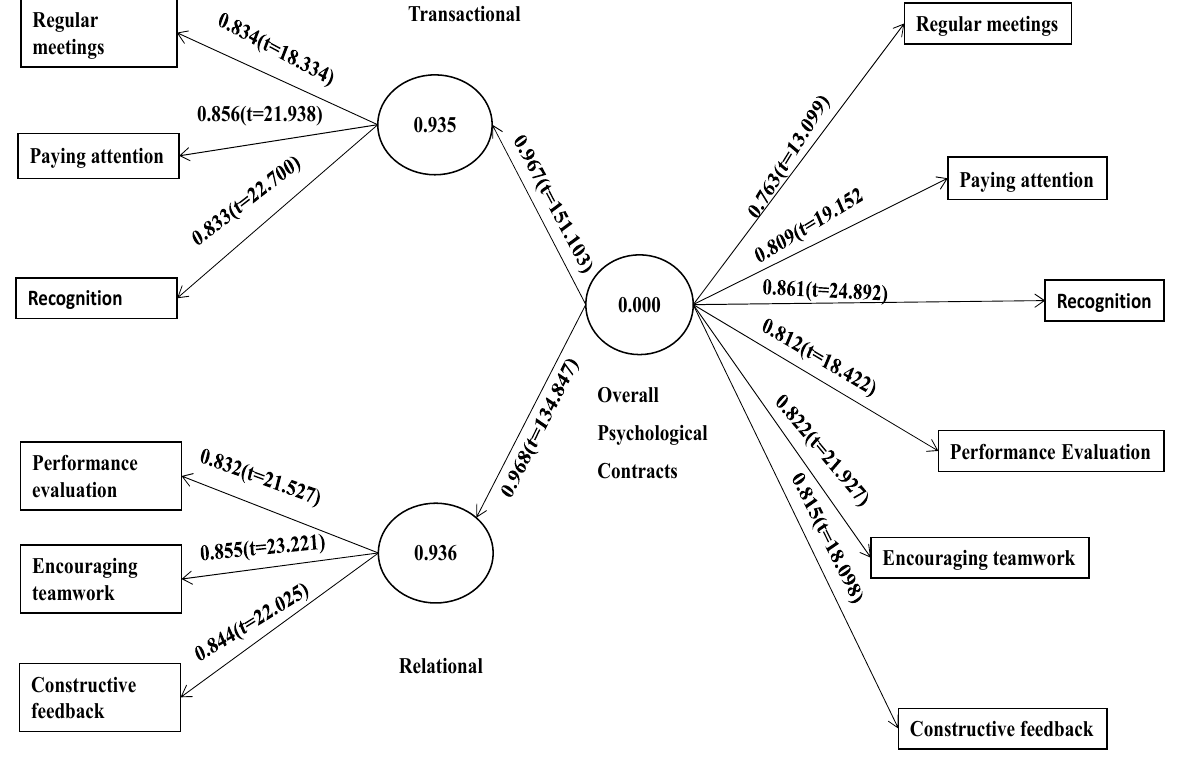
Figure 3. Main Loadings of the Model.